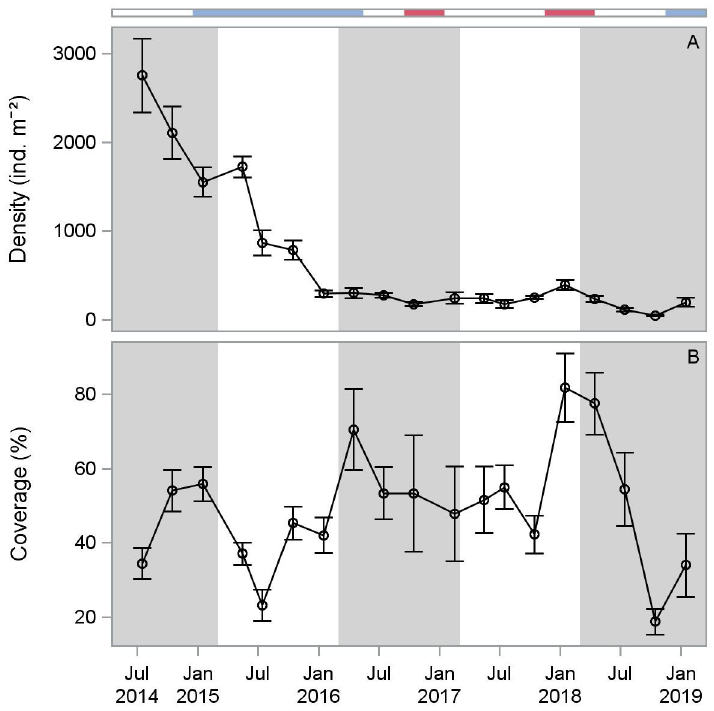
Fig 3. Mean oyster density (A) and percent areal coverage of reef substrates (B) on constructed sites from July 2014-January 2019. Colors on horizontal bar indicate ENSO state: light blue = El Ni ñ o, red = La Ni ñ a.